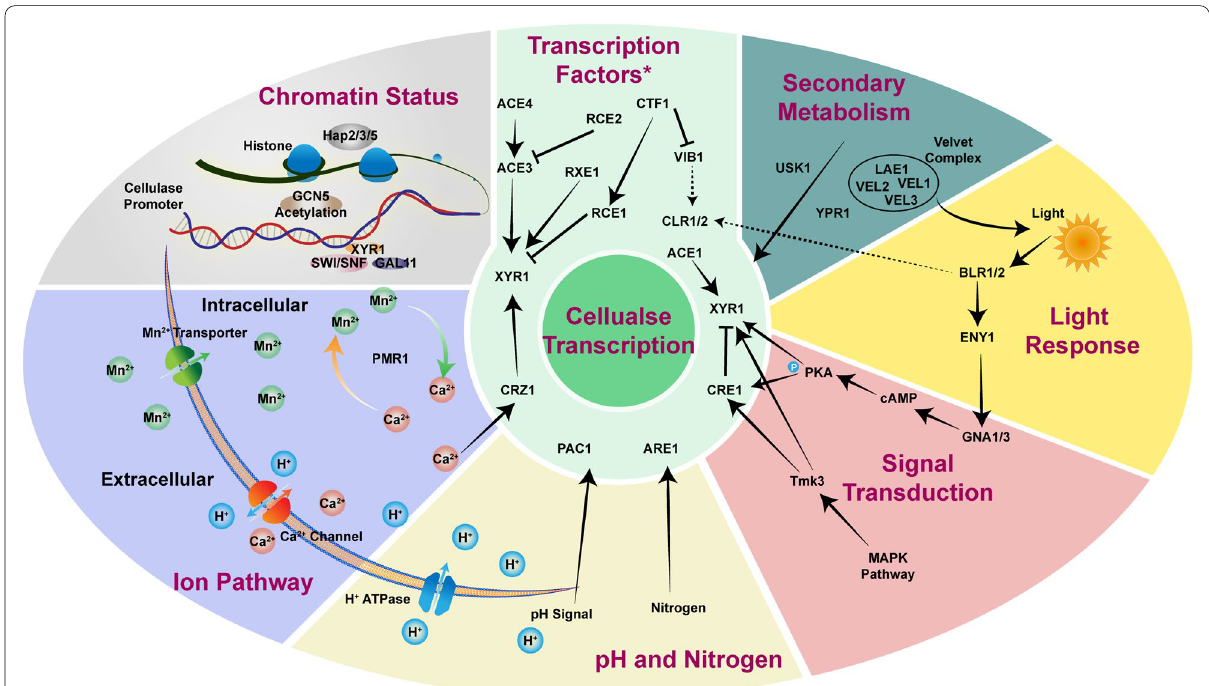
Fig. 2 Cellulase regulation at the transcription level. In T. reesei , transcription of cellulase is under complicated and coordinated regulation networks including transcription factors, signal transduction, chromatin status, secondary metabolism and environmental factors such as light, nitrogen source, pH and metal ion, which are depicted in different areas with diverse colors. Only the factors involved in the crosstalk with other factors and pathways are depicted in the picture. The inter‑regulation of different factors and regulators is shown by black arrows and lines. The dashed lines indicate characterized regulation mechanism in other fungi but not in T.